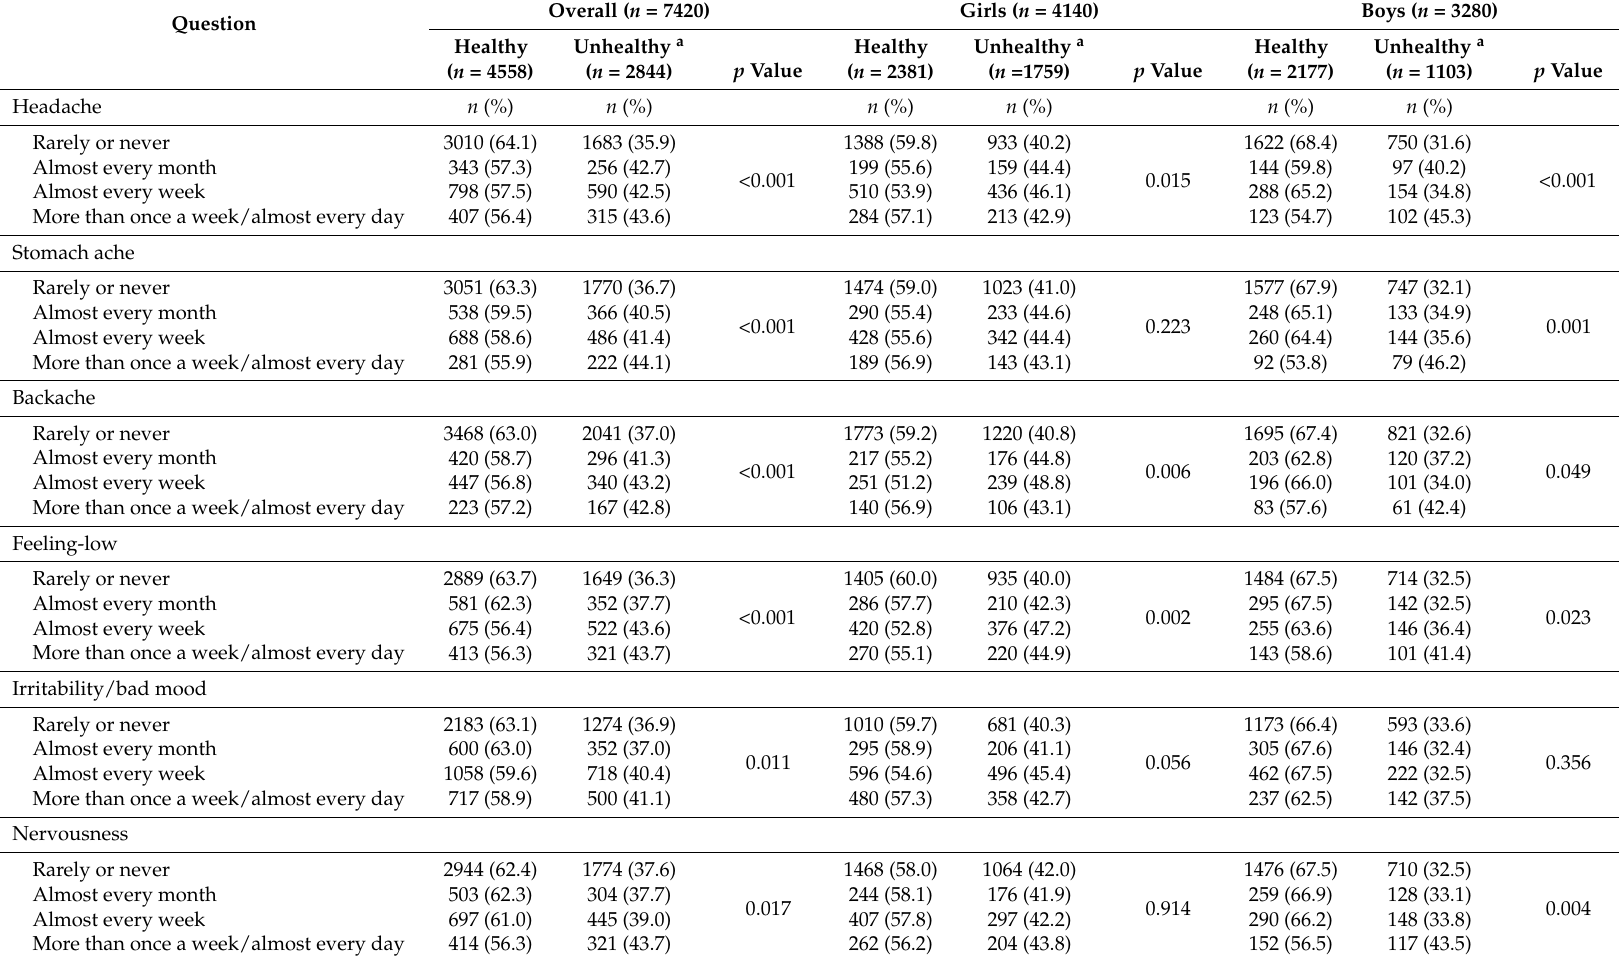
Table 3. Relationship between self-rated health status and cardiorespiratory fitness in a sample of schoolchildren from Bogot á , Colombia. The FUPRECOL